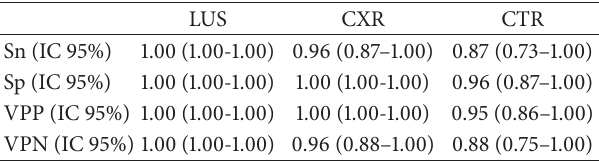
Table 2: Sensitivity and specificity and positive and negative pre- dictive value of LUS, CXR, and